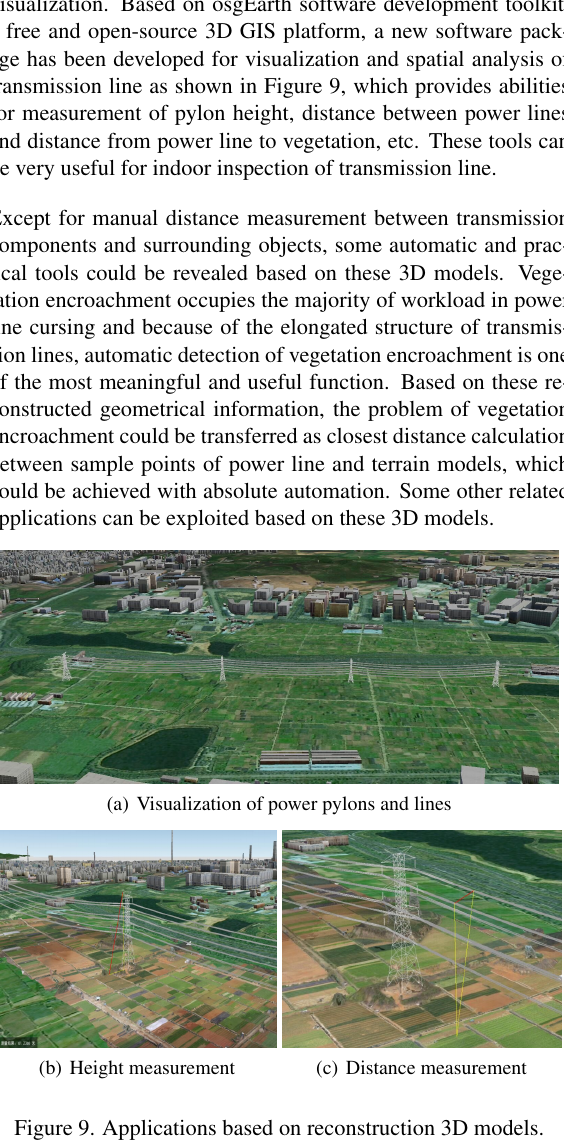
Figure 9. Applications based on reconstruction 3D